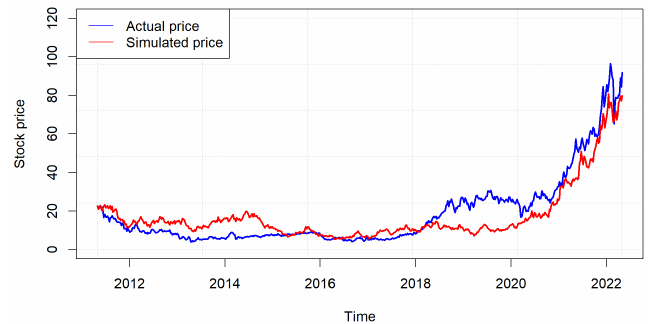
Figure 16. GBM Simulation